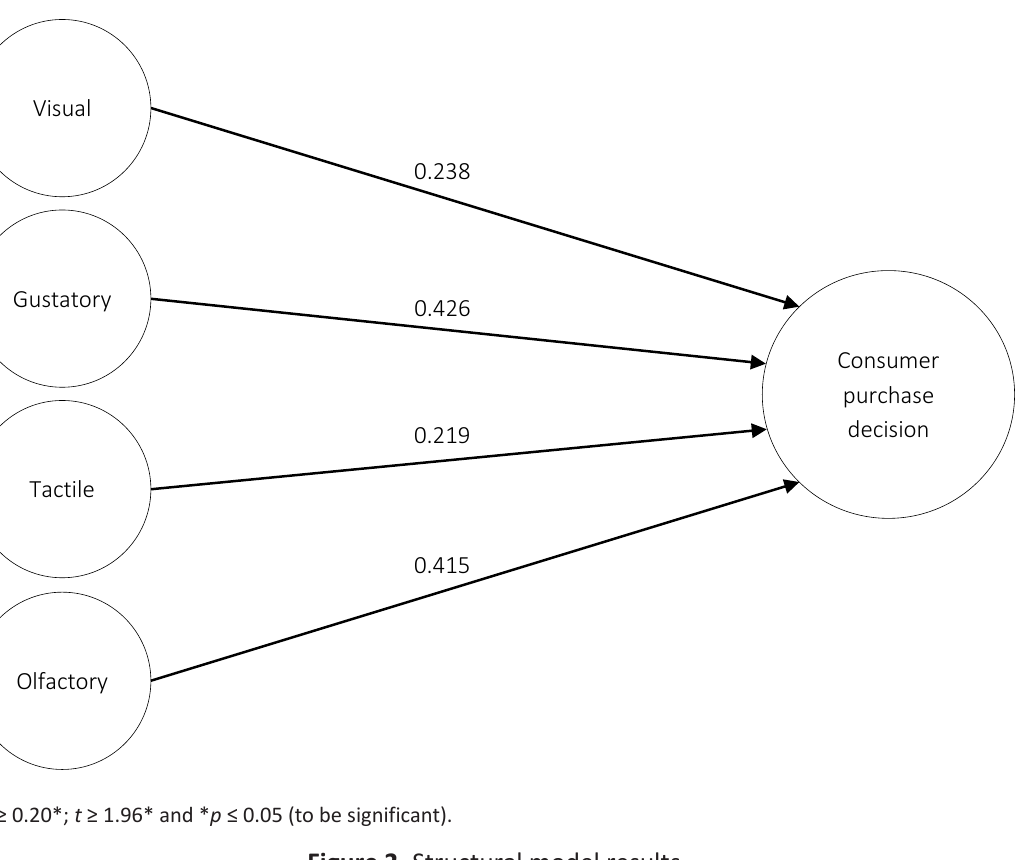
Figure 2. Structural model